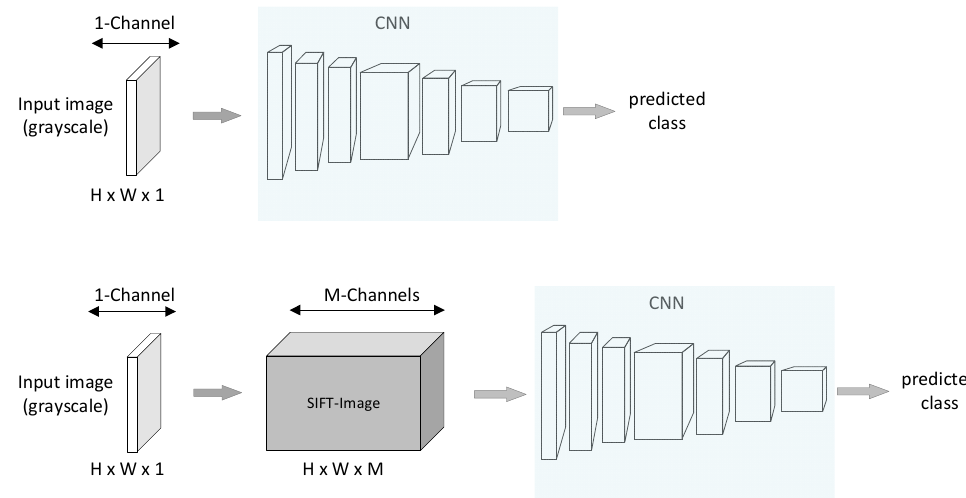
Figure 2. Overview of the Pixel-CNN and SIFT-CNN frameworks for image classification. Top scheme: Pixel-CNN, the regular implementation of CNN where pixel values of the grayscale image are used directly as inputs into CNN. Bottom scheme: SIFT-CNN, the SIFT image representation is used as input into a CNN, and thus, the SIFT-CNN is guided to learn features from the local gradient information of images, which allows SIFT-CNN to implicitly incorporate a local rotation invariance property.